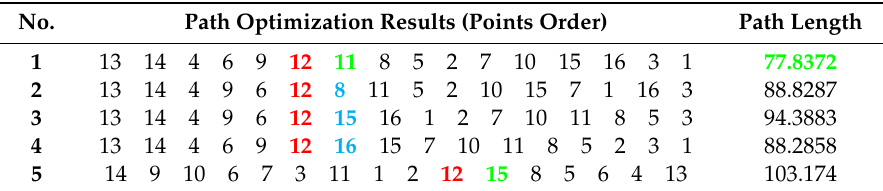
Table 2. Partial path optimization results under ulysses16 data.